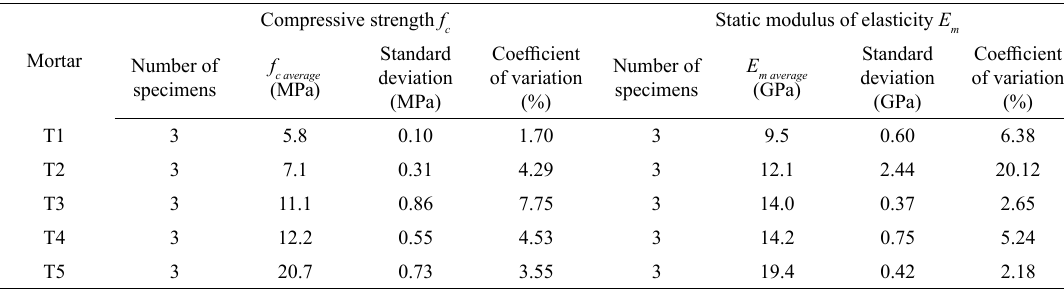
Table 6. Results of (5 x 10) cm cylindrical